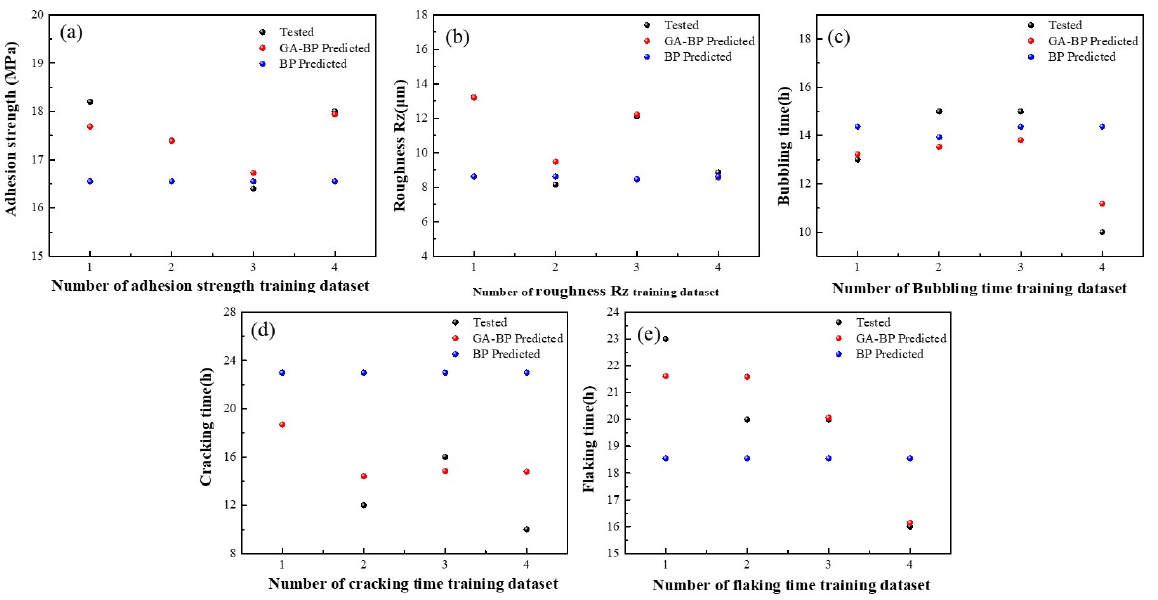
Figure 13. The prediction results of the BP and GA–BP regression model: ( a ) adhesion strength; ( b ) roughness; ( c ) bubbling time; ( d ) cracking time; ( e ) flaking time.